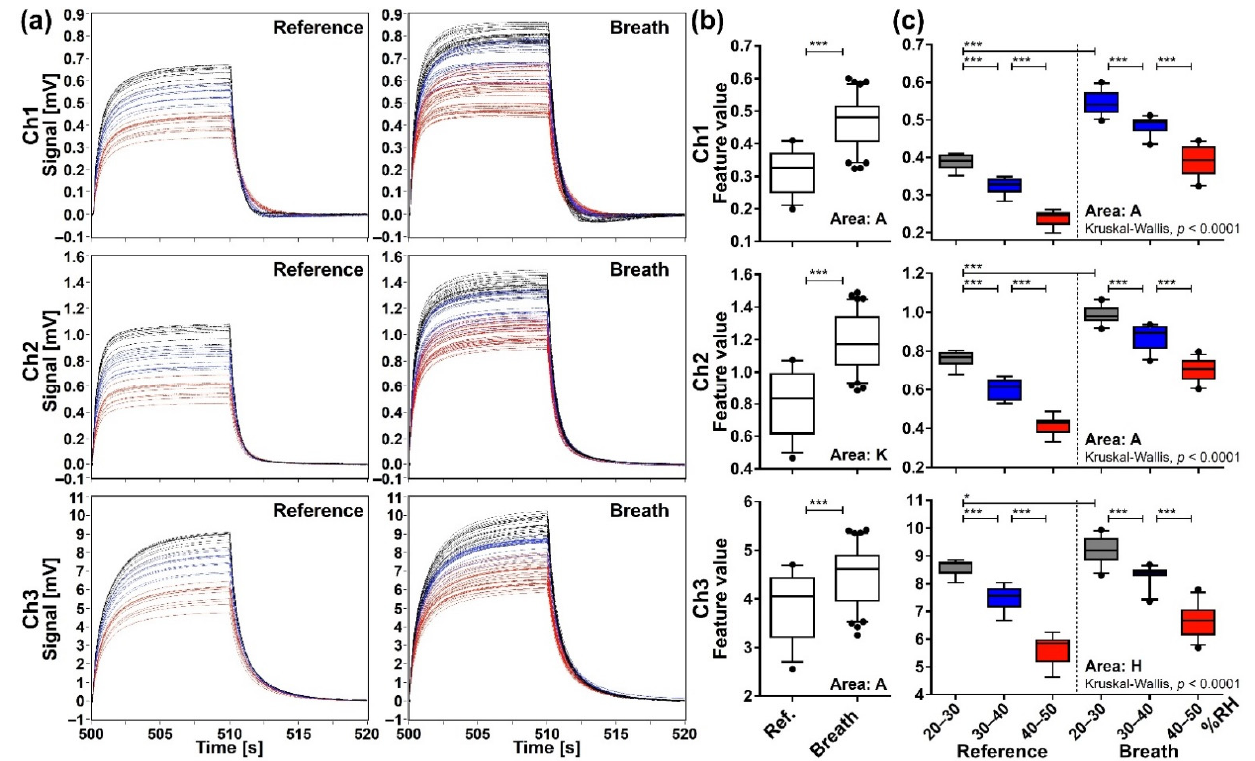
Figure 5. Sensing data processed by the start-point offset method. ( a ) The waveforms of reference ( n = 33) and breath ( n = 83) samples. ( b ) Comparison of feature values between reference and breath samples evaluated by the two-tailed Mann-Whitney U test (***, p < 0.0001). ( c ) Comparison of feature values among subgroups categorized by RH range of the purge gas: grey for 20–30% RH (reference n = 10, breath n = 24); blue for 30–40% RH (reference n = 12, breath n = 25); and red for 40–50% RH (reference n = 11, breath n = 34). Box plots represent the results of Kruskal-Wallis test and post-hoc Mann-Whitney U test with Bonferroni correction (*, p < 0.01; ***, p < 0.0001); horizontal lines, lower and upper edges of each box, and whiskers corresponds to medians, 25–75 percentile regions, and 5–95 percentile regions, respectively.